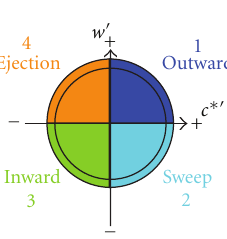
Figure 13: The scheme of event definitions used in turbulent flux quadrant